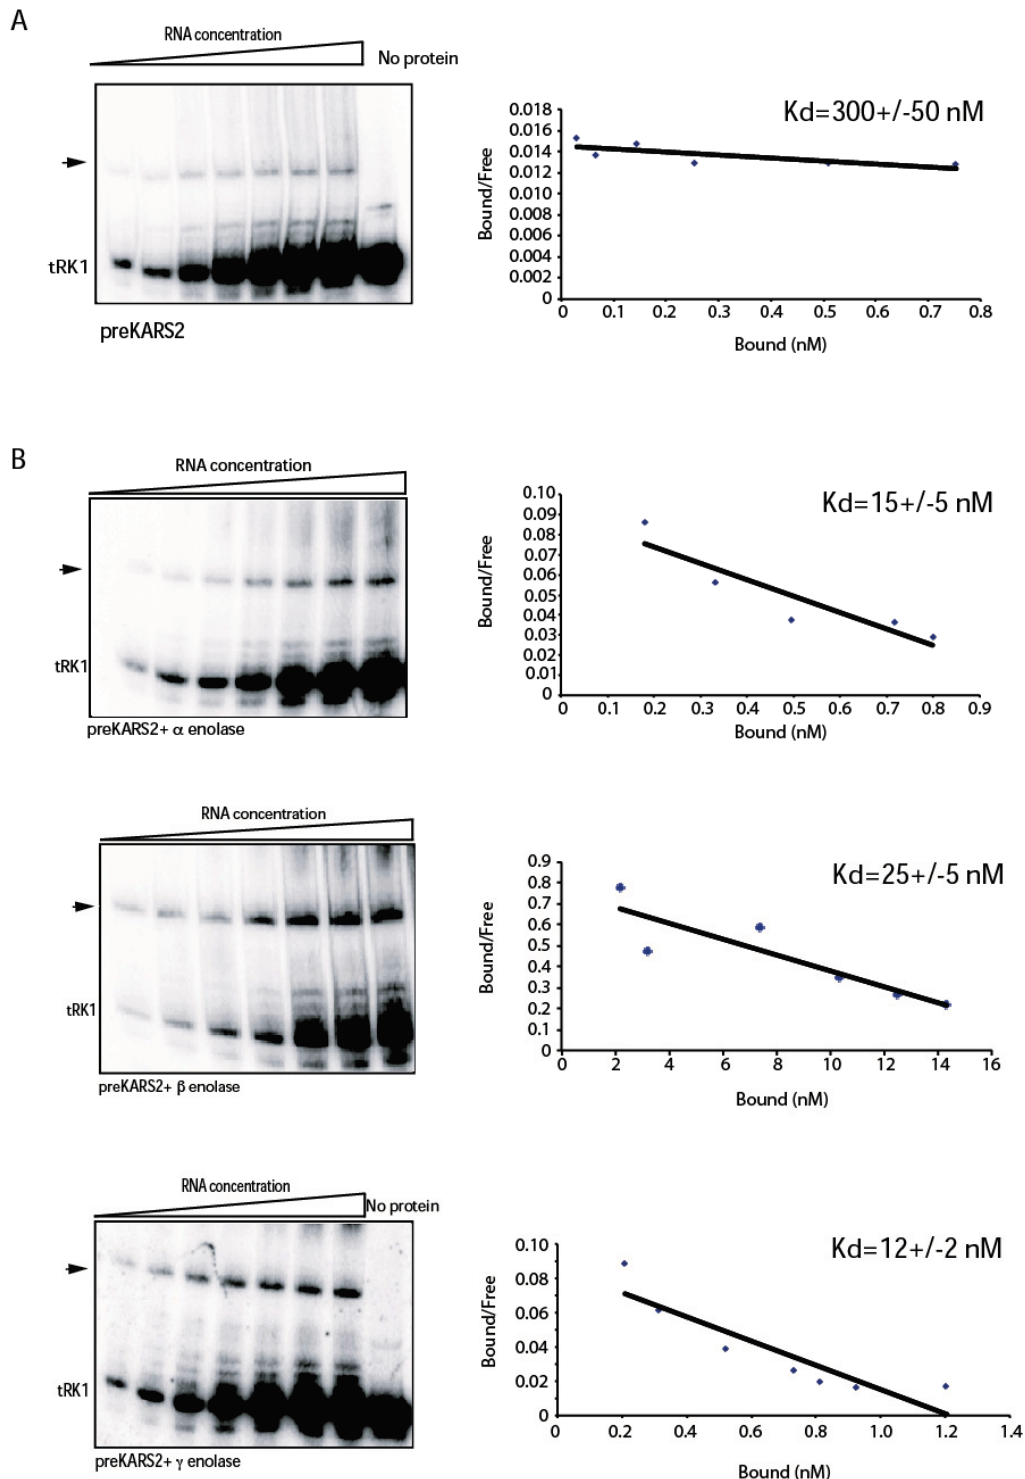
Figure 5. Interaction between labeled tRK1 and preKARS2 in the absence or presence of human enolases. Scatchard plot determination of dissociation constants for preKARS2–tRK1 complex in the absence of enolase ( A ); or in the presence of various isoforms of human enolases, as indicated below the panels ( B ). The bottom band corresponds to the free tRK1; preKARS2–tRK1 complex is shown with an arrow. One example from three independent experiments is presented, K d ± SD is indicated at the